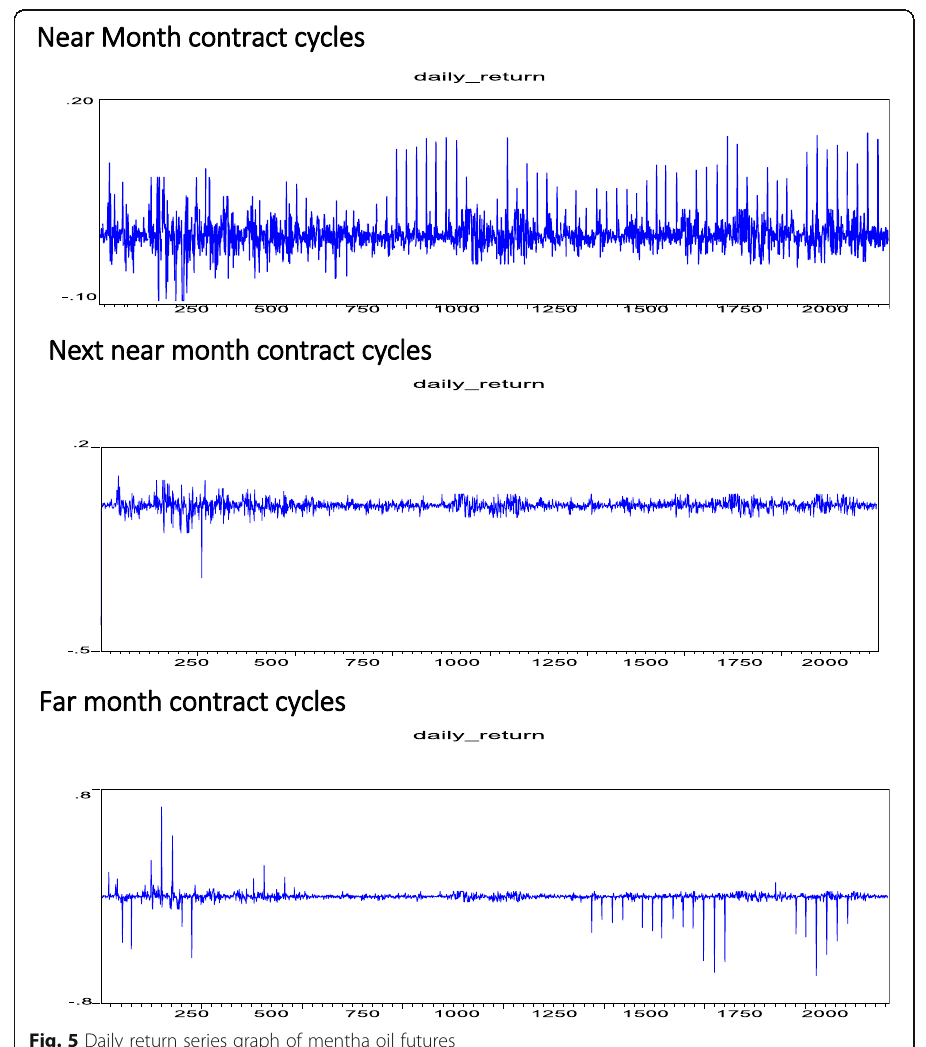
Fig. 5 Daily return series graph of mentha oil